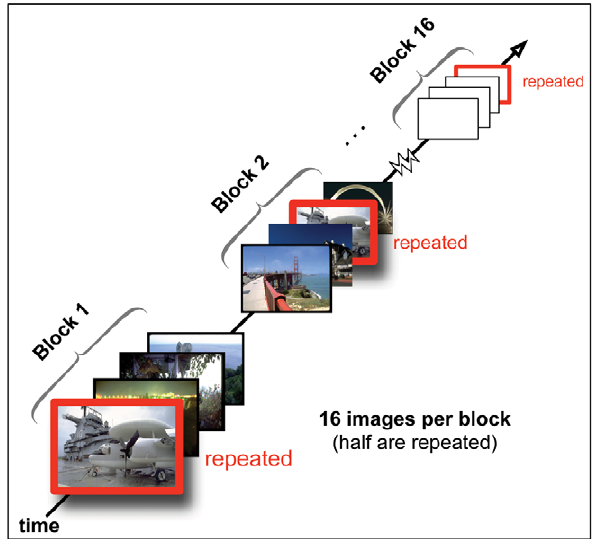
Figure 3. Contextual cueing paradigm. Participants search for a target in an image, and response times are observed. The paradigm assumes that spatial memory of the scene facilitates search for scenes that are repeated. A contextual cueing effect is observed if search is progressively speeded for repeated scenes compared to novel scenes as a function of block [7]. Here, the block design used in Experiments 2 and 3 is illustrated, consisting of 16 blocks, each containing 8 novel and 8 repeated images, randomly arrayed. (Blocking in Experiment 1 differed, employing 30 blocks of 24 trials, with 12 repeated images per